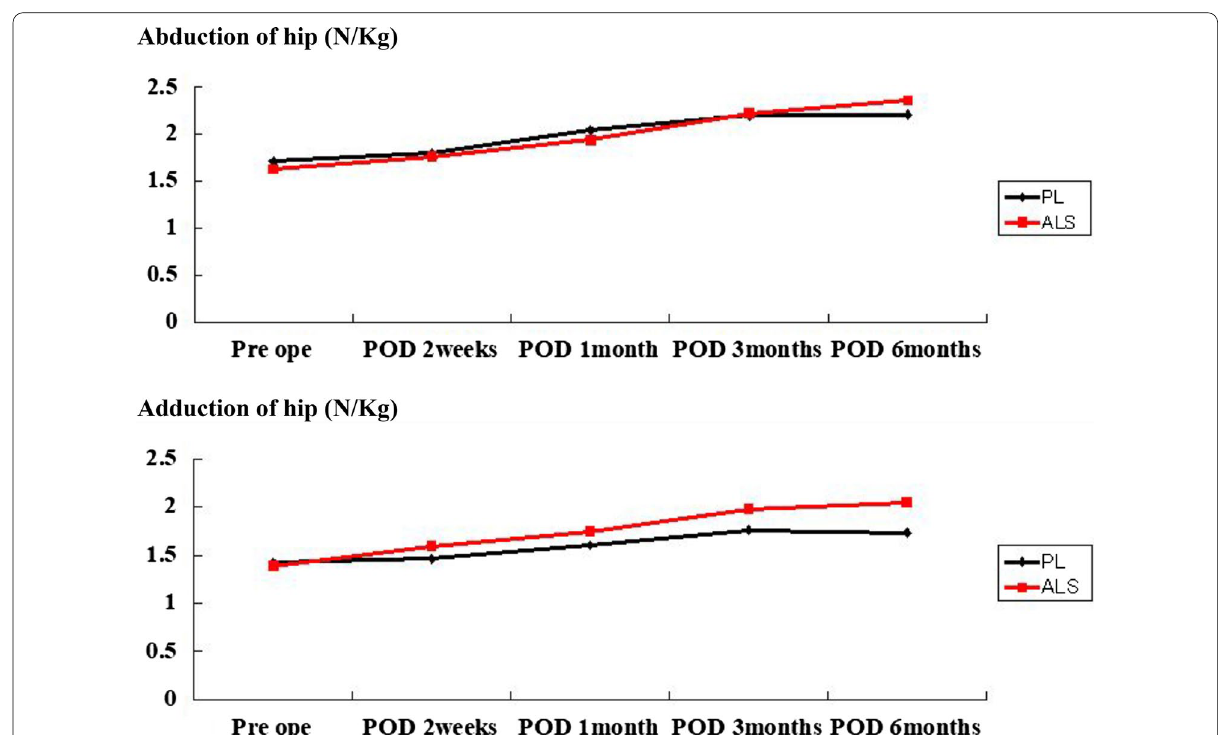
Fig. 2 Evaluation of muscle strength of hip abduction and adduction. No significant difference was found in hip abduction or adduction between the two groups. ALS: anterolateral supine; PL: posterolateral; POD: postoperative